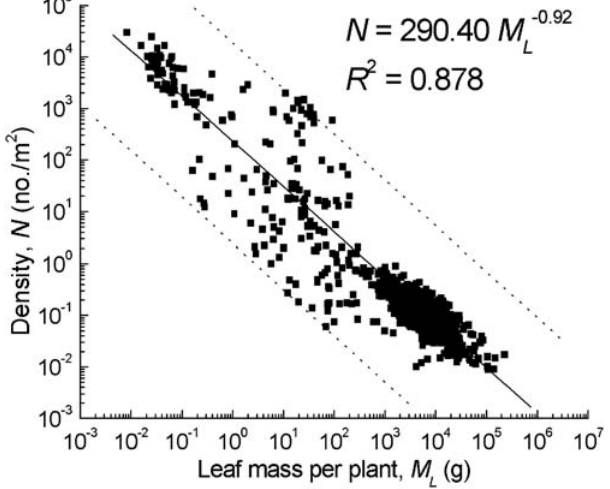
Figure 4. The allometric relationships between population density and photosynthetic mass or leaf mass for trees, desert shrubs and monoculture herbaceous plants (spring wheat). The regression is significant at P , 0.0001 and the exponent approximates to the theoretical value of 2 1 (also see Table 1, 2).